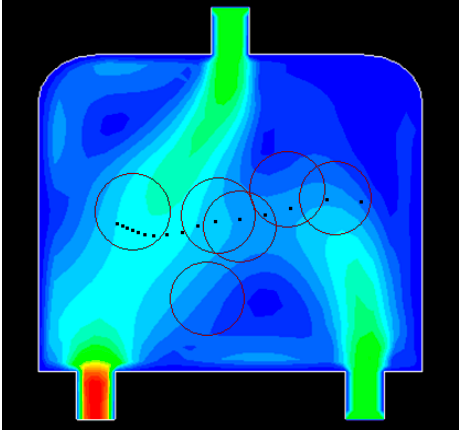
Figure 11. The distribution of events and sensors at t2.